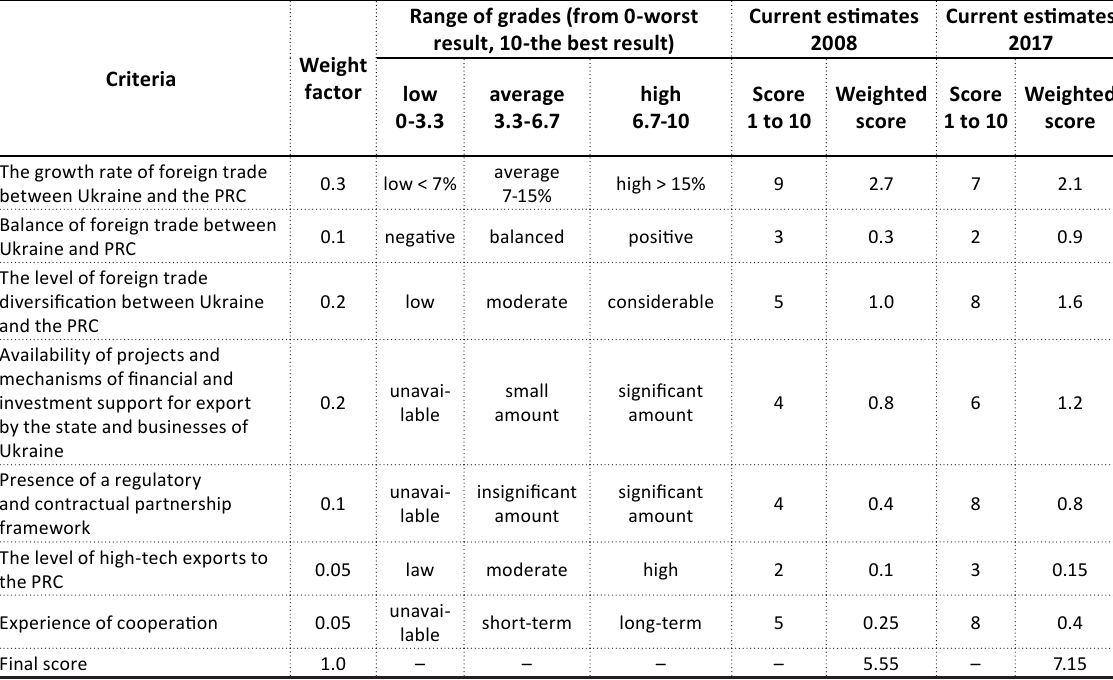
Table 4. Integral index of regulatory effectiveness of promoting Ukraine’s export to the PRC in 2008 and